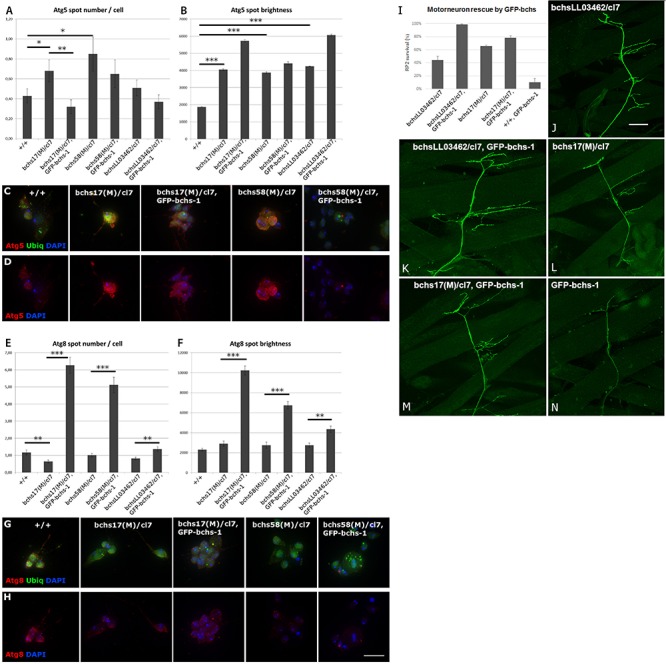
Full-length Bchs drives an increase in transition of early Atg5-positive vesicles to Atg8-carrying autophagosomes, and full-length Bchs rescues bchs neuronal loss, but kills motor neurons in a wild-type background. (A,B) Early autophagic Atg5-positive vesicle number and brightness (fluorescence intensity per pixel within a spot) in primary larval neurons, with examples of neurons of individual genotypes (C,D), also labeled with anti-poly-ubiquitin (green) and DAPI (blue) to show cell locations. *p < 0.05, ∗∗p < 0.01, ∗∗∗p < 0.001. (E,F) Late autophagic Atg8-positive vesicle number and brightness in the same genotypes as in (A,B); examples shown in (G,H). Atg5/Atg8 and DAPI are shown separately to make changes in abundance of the respective marker more visible. Scalebar = 10 μm. (I–N) RP2 motor neuron survival after GFP-bchs-1 expression via eve-Gal4 in bchs mutant backgrounds bchsLL03462/cl7, bchs17(M)/cl7, or in the control background (+/+). (J–N) Images of representative neuromuscular junctions in the larval body wall labeled with eve>GFP in the same bchs backgrounds, with or without GFP-bchs-1. Scalebar = 20 μm.